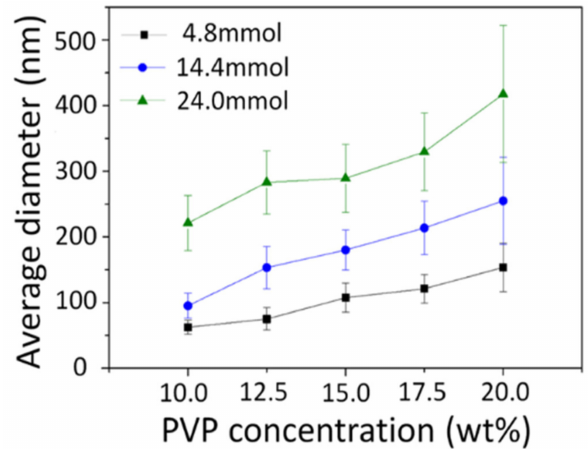
Figure 7. Average diameters of calcined Ni 0.5 Zn 0.5 Fe 2 O 4 nanofibers obtained from each precursor